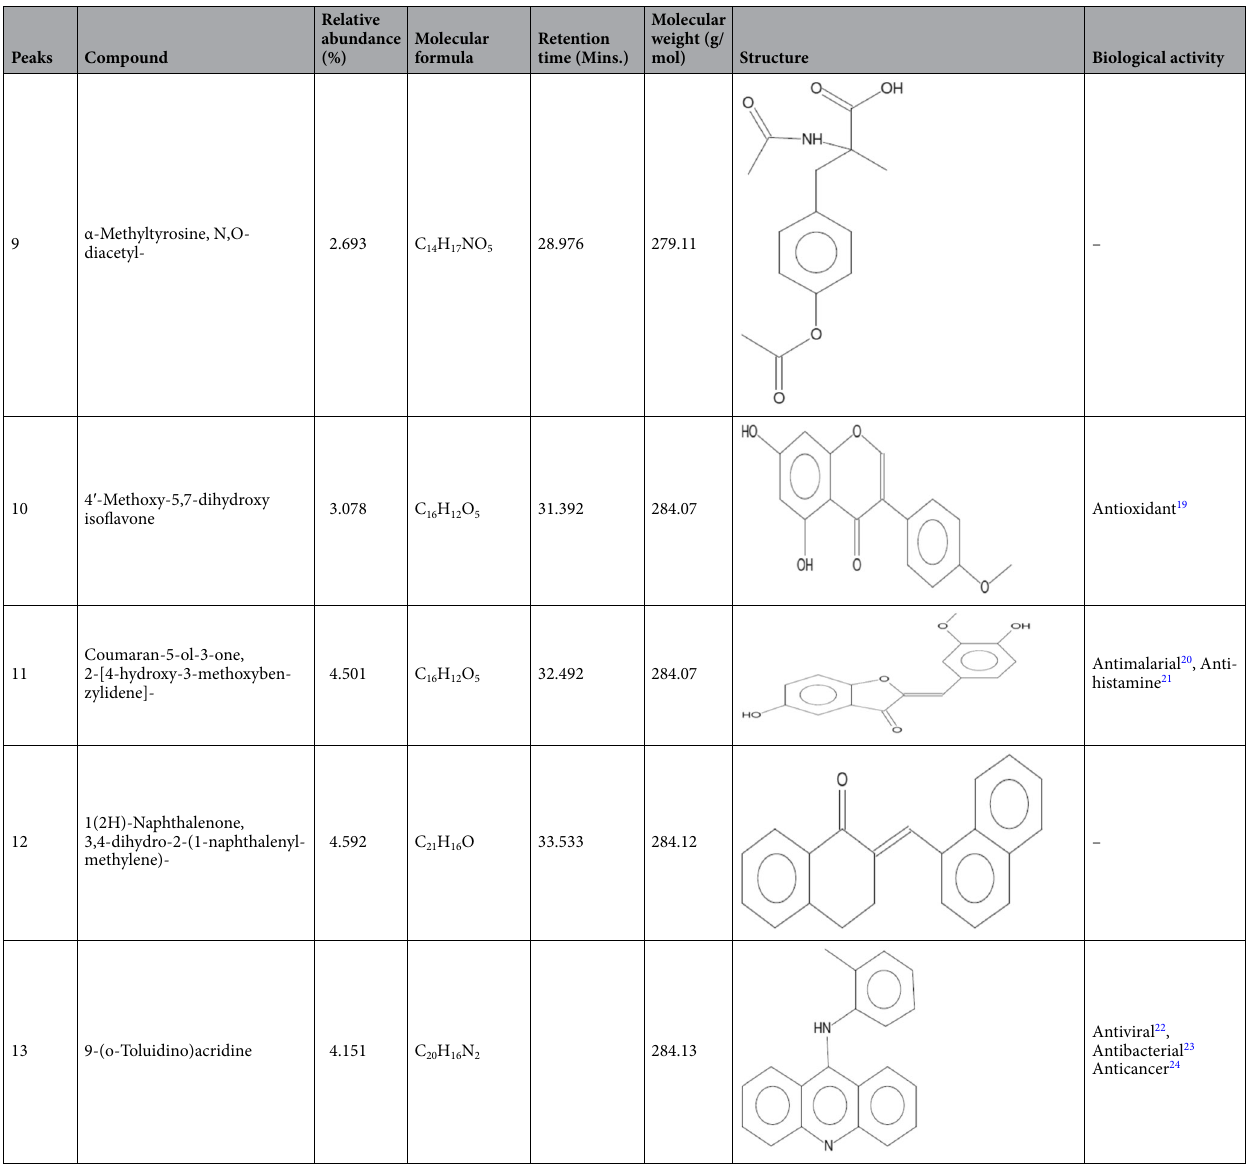
Table 4. Bioactive compounds identified in methanol extracts of X. aethiopica